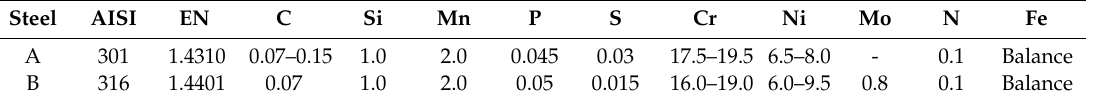
Table 1. Chemical composition of steel A and B (Alloying elements